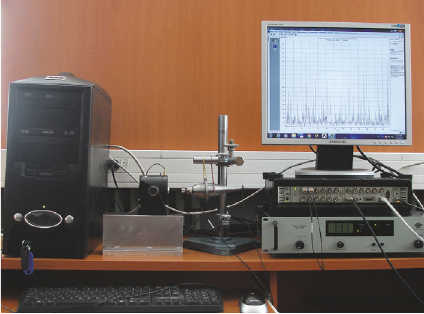
Figure 11: The detailed connection shaker horn.